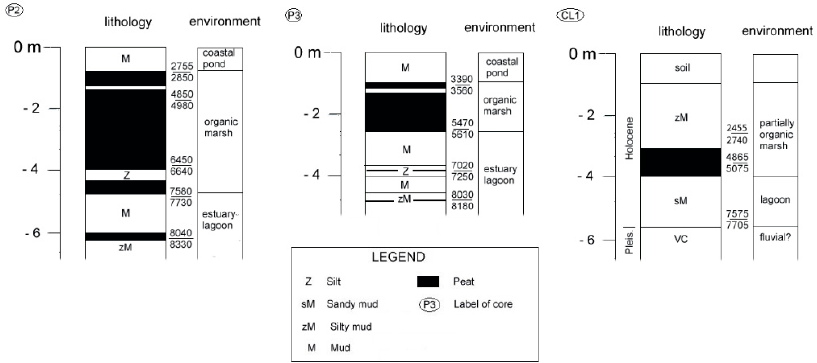
Figure 10. Lithological/environmental diagram of some boreholes carried out in the Campania area. P2 and P3 are percussion boreholes; CL1 is rotating boreholes. P2 and P3 are modified after [36]; CL1 is modified after [111].